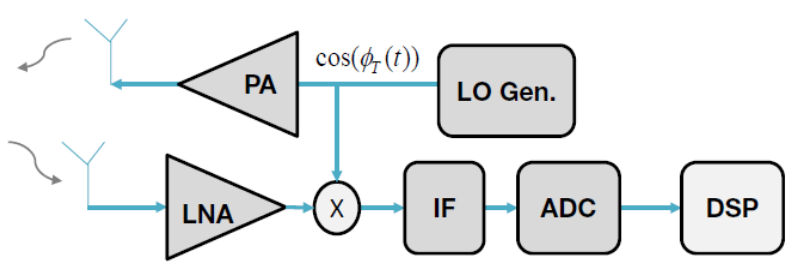
Figure 5. High-level block diagram of an FMCW RADAR system.